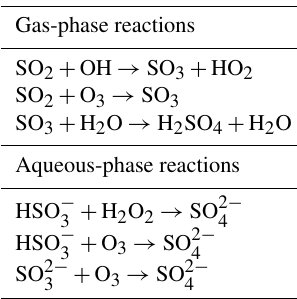
Table 1. Summary of SO 2 oxidation chemistry in